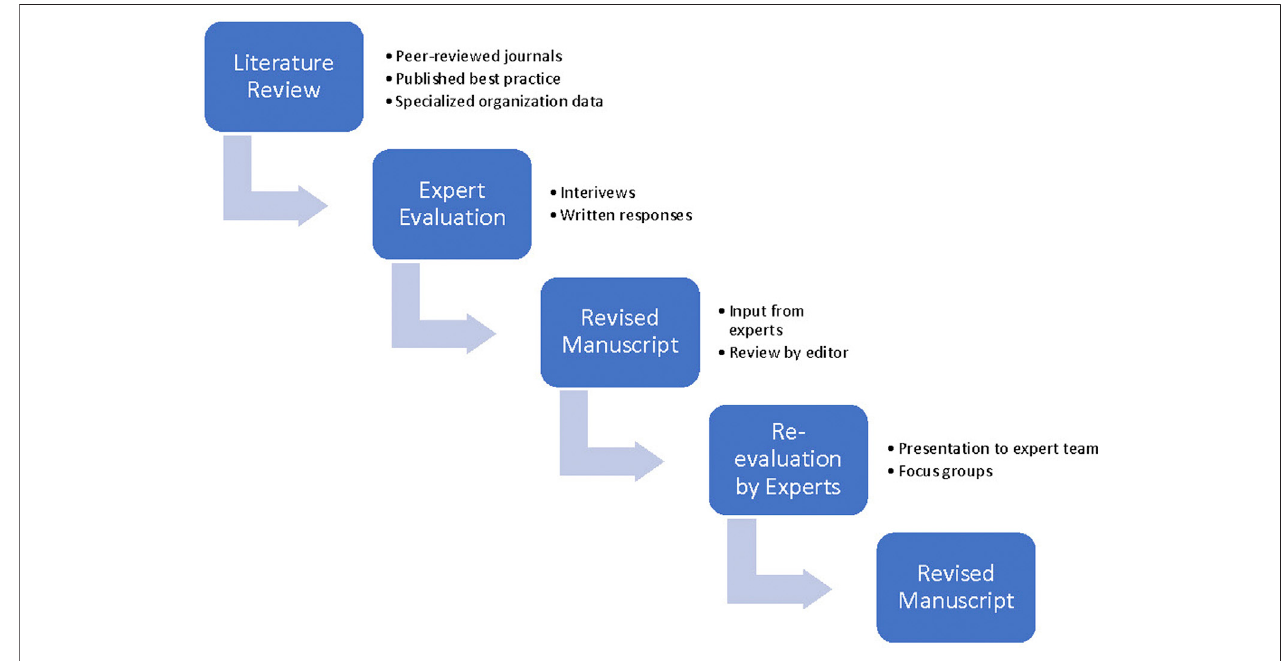
FIGURE 3 | Overall